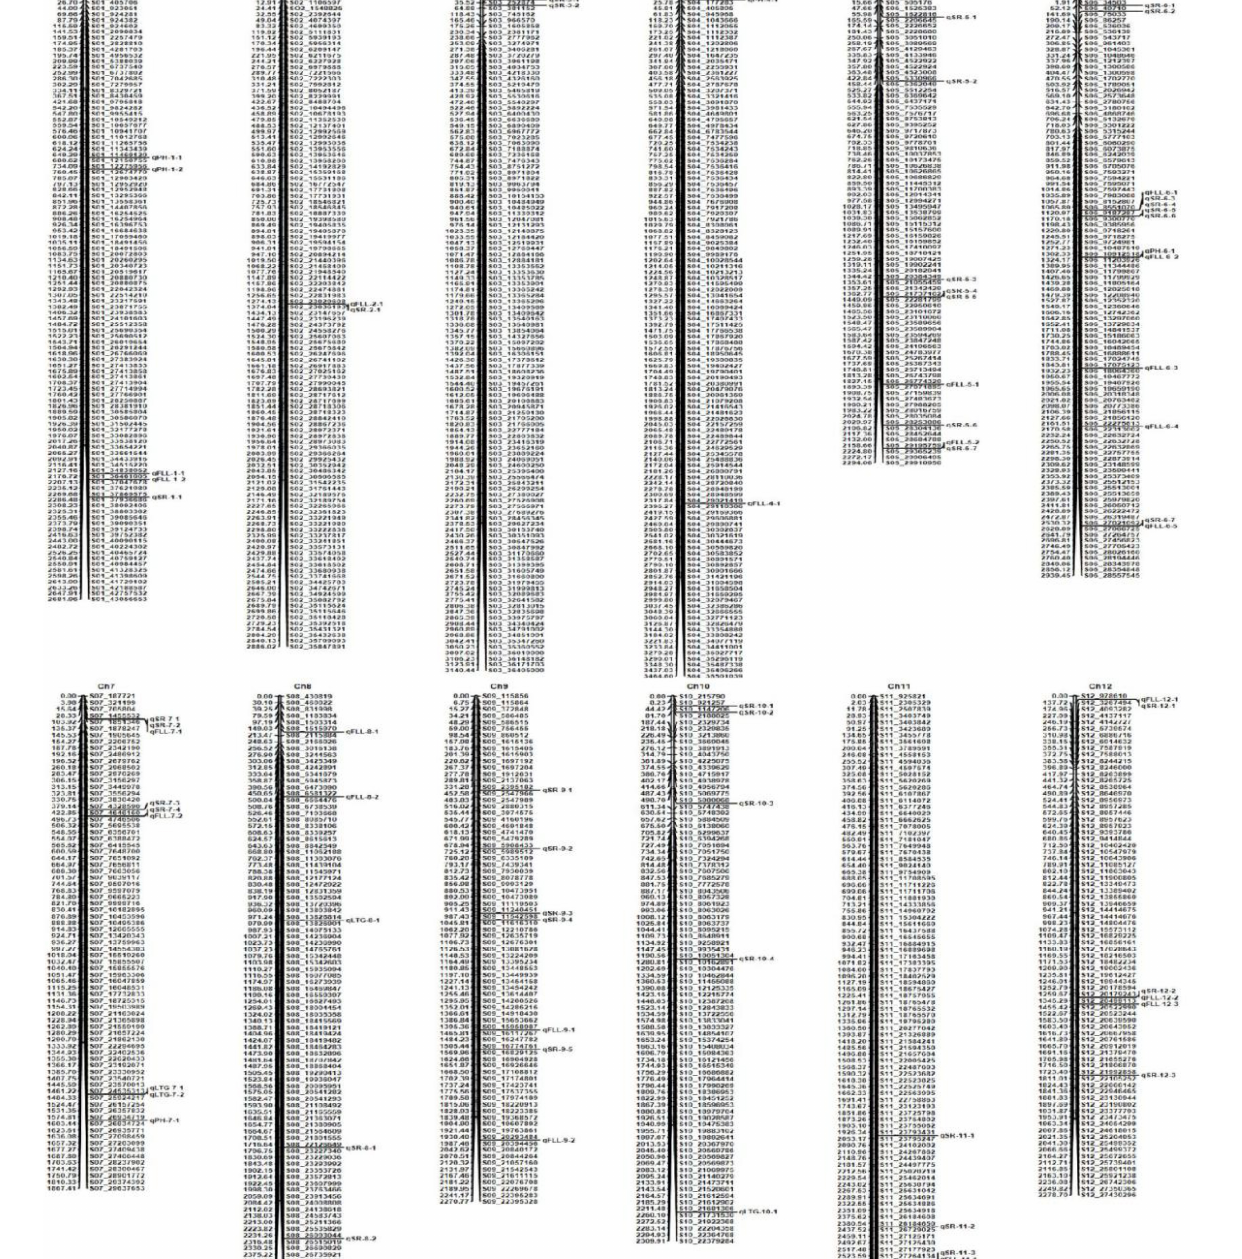
under cold stress and 12 were localized under BR-combined cold treatment, respectively. Intervals between some QTLs under both cold stress and BR-combined cold treatment were coincident,